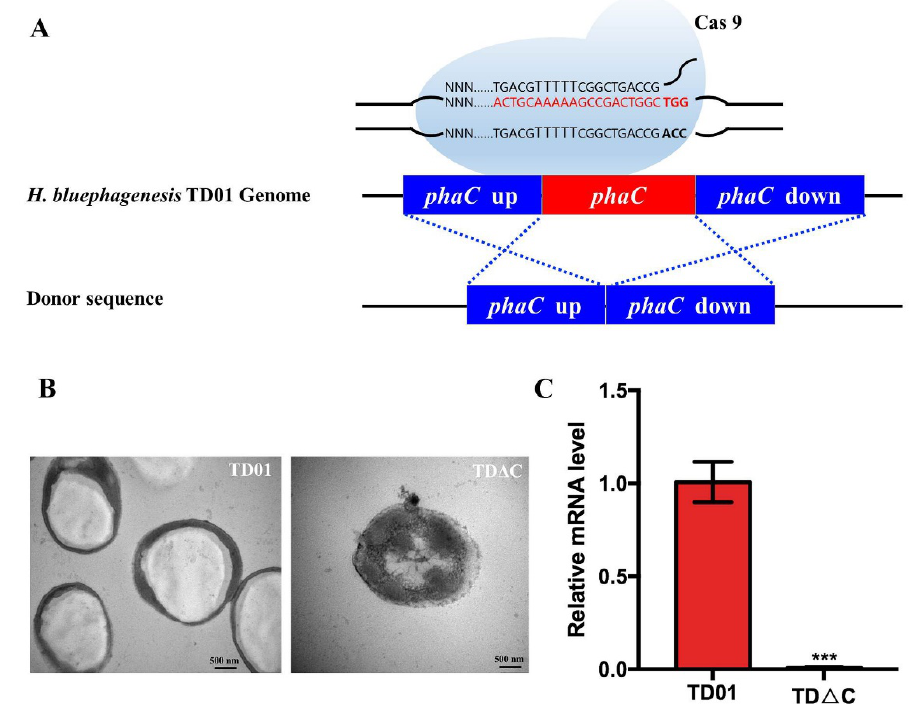
Figure 2. Identifications of PhaC Hb knockout mutant H. bluephagenesis TD Δ C : ( A ) PhaC Hb knockout procedure by CRISPR-Cas 9 method using 500-bp homologous arm upstream and downstream of the phaC Hb gene; ( B ) TEM observation of wild-type H. bluephagenesis TD01 (left) and H. bluephagenesis TD Δ C (right). Bar: 500 nm; ( C ) Relative mRNA level of phaC Hb gene in wild-type and knockout mutants determined by RT-qPCR. *** means p < 0.001.